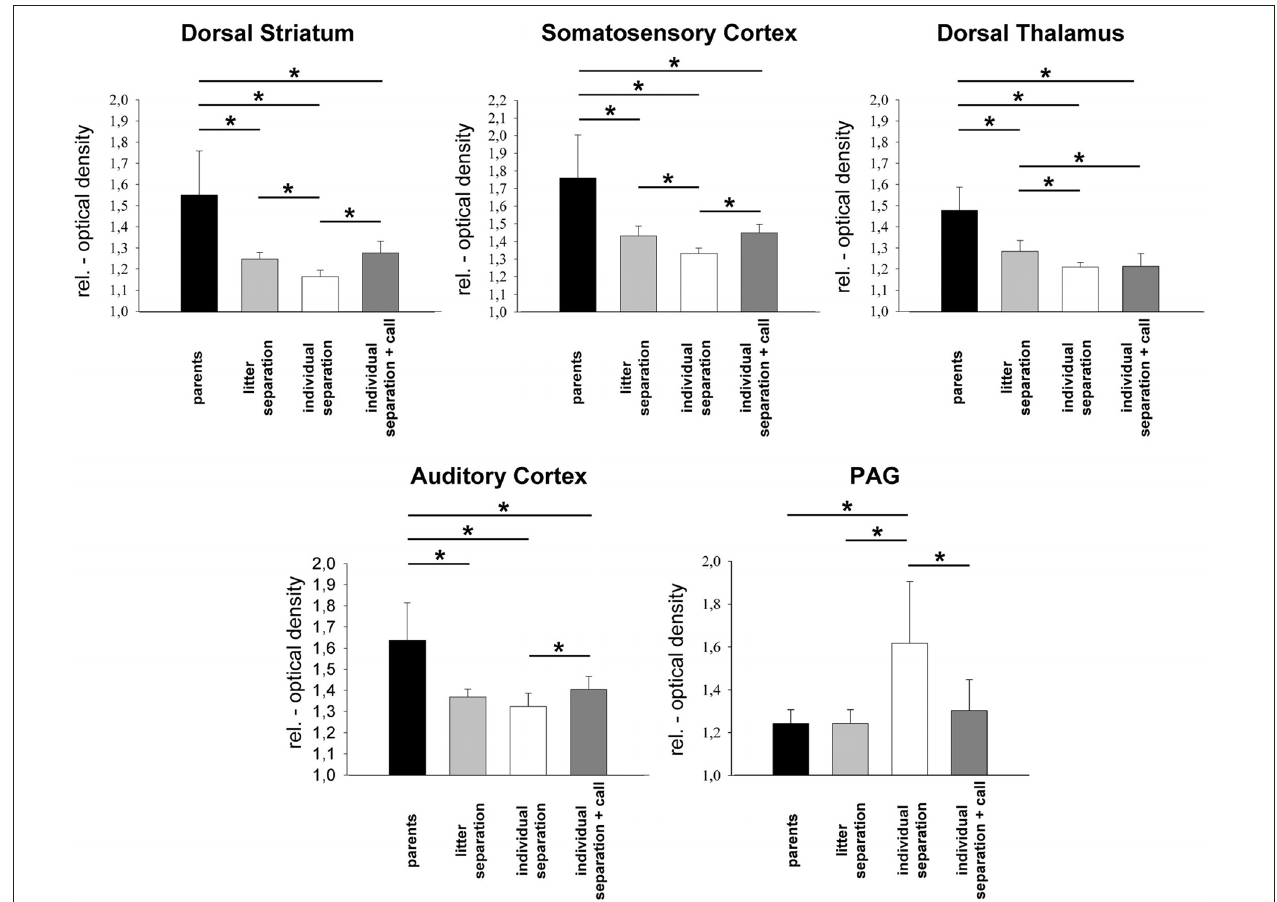
FIGURE 3 | Relative optical density of sensory and subcortical brain areas in the four experimental groups. ∗ p ≤ 0.05, Mann–Whitney U -test. PAG, periaqueductal